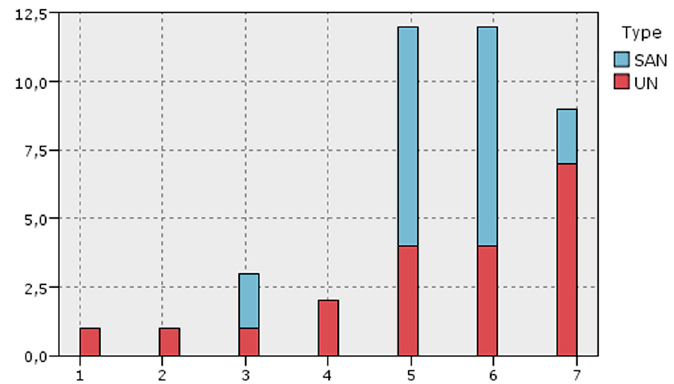
Figure 6. Participants’ satisfaction with the negotiation process that they experienced during the case study. UN = unassisted negotiation; SAN =smart assisted negotiation.